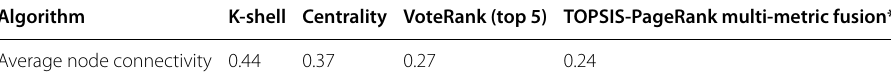
Table 6 Connectivity after a key node is delete